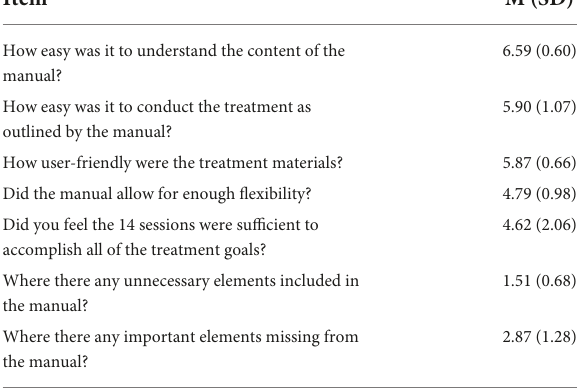
TABLE 8 Implementation of manual content—Summary therapist feedback form